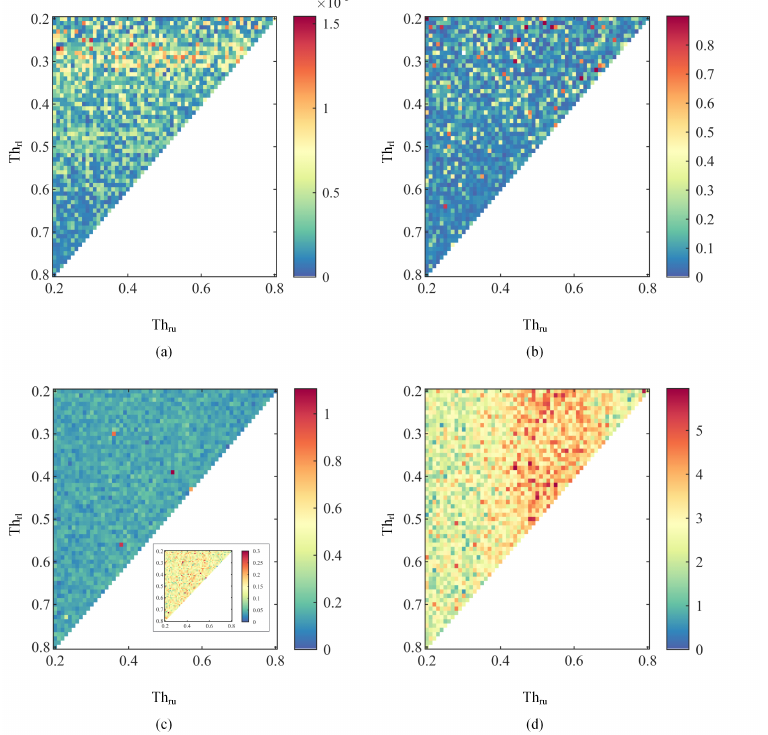
Figure 11. Calibration accuracy of the proposed scheme under different R tude and phase errors of α ; ( c , d ) amplitude and phase errors of k